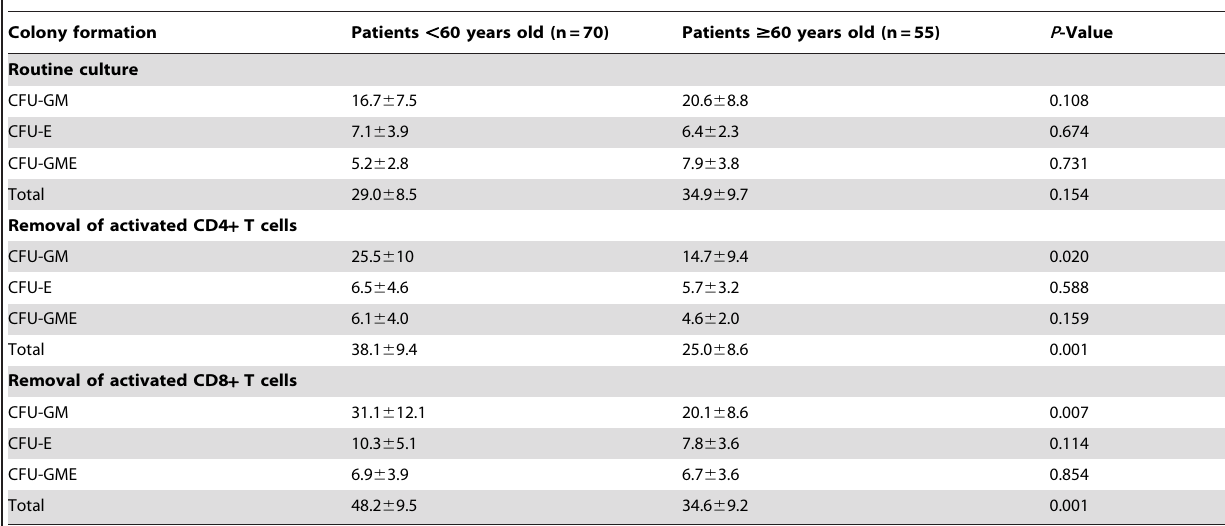
Table 3. In vitro colony formation assay of both younger and older MDS patients.